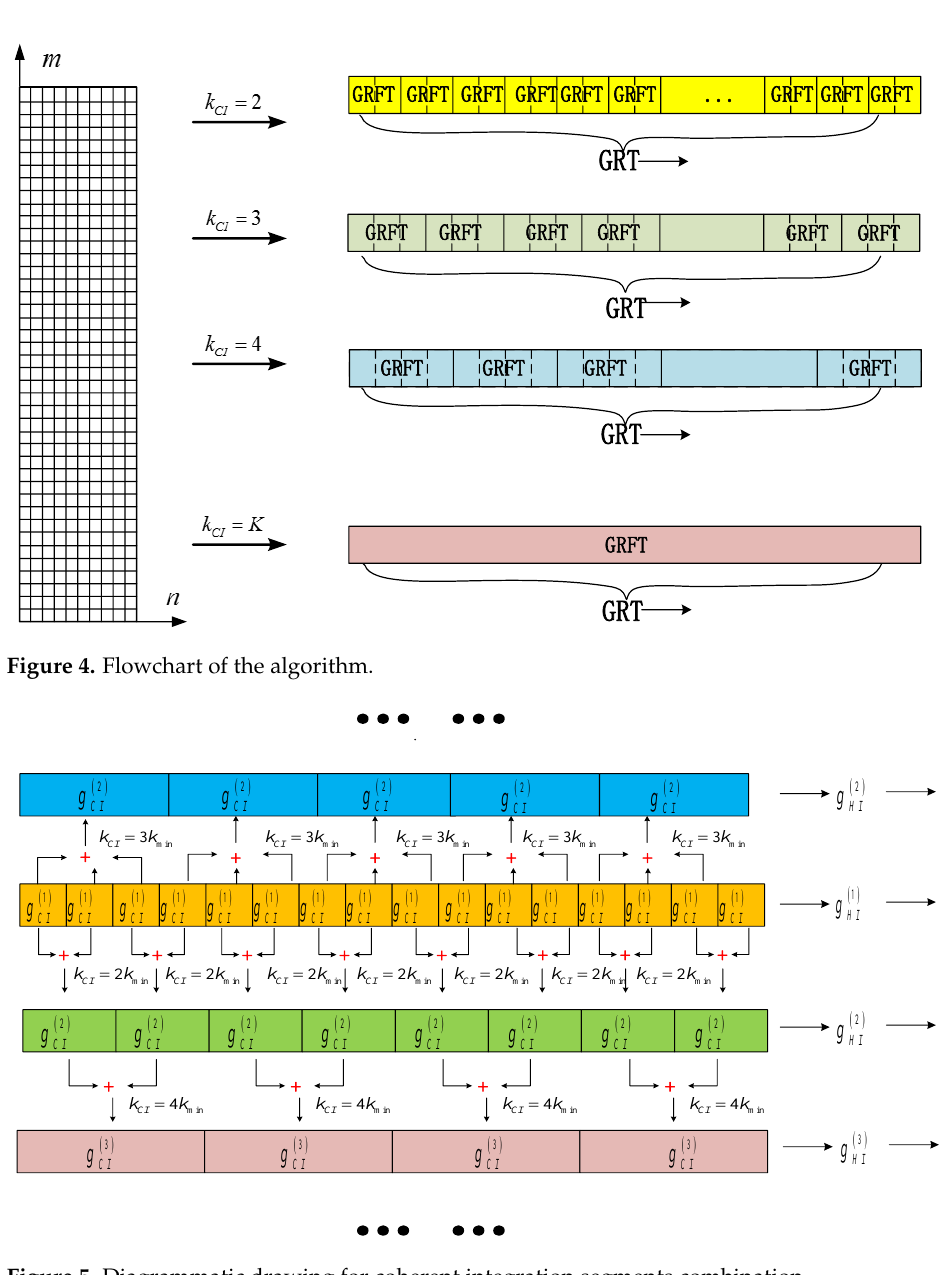
Figure 5. Diagrammatic drawing for coherent integration segments combination.